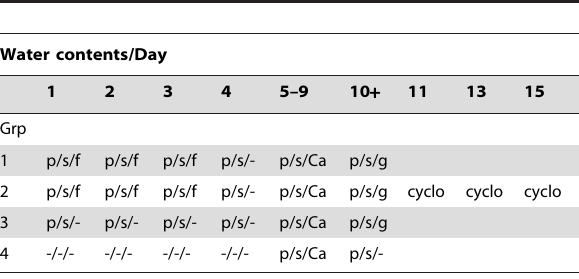
Table 1. Pilot experiment treatment schedule examining multiple